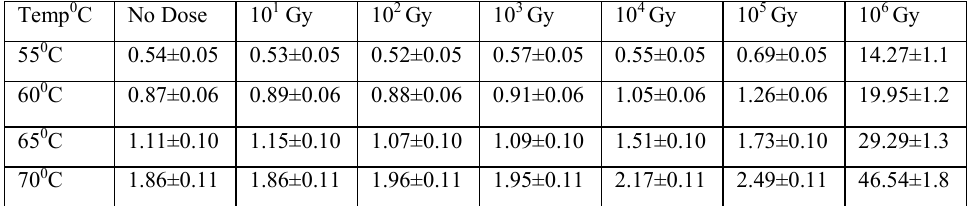
Table 2. Track-Etch rate (V ) in µm/h for pre-gamma exposed PADC –American Acrylics. T